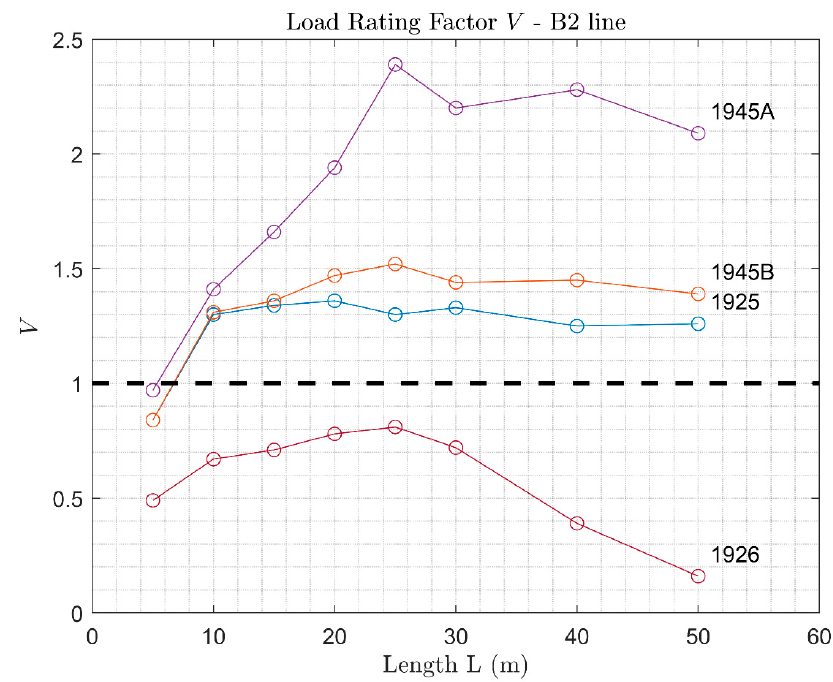
Figure 11. Load Rating Factor of arches verified with B2 loads.